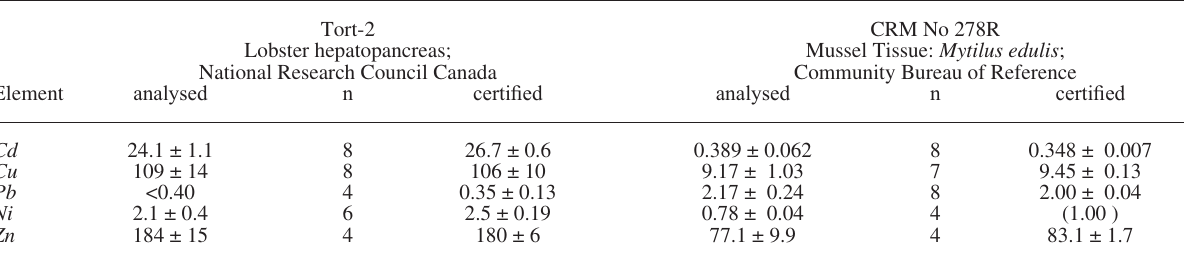
Table 1. – Quality assurance using certified reference materials randomly allocated within the